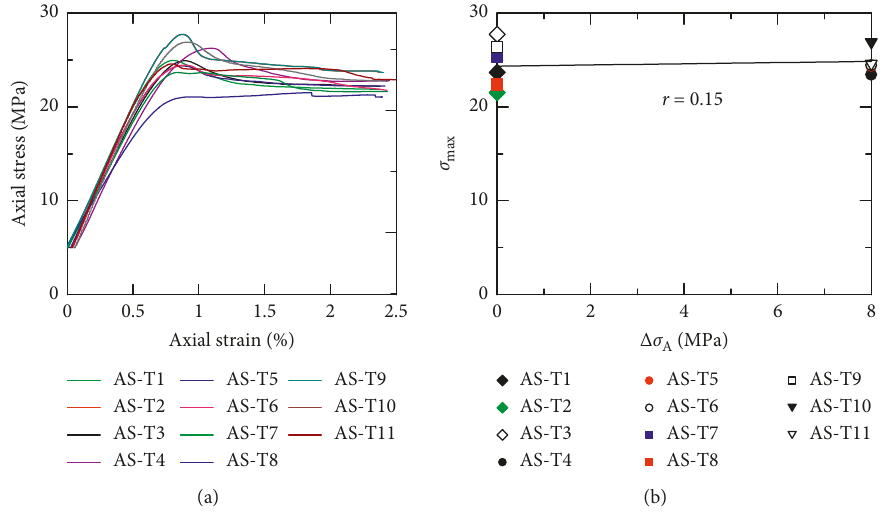
Figure 15: (a) Stress-strain curves and (b) maximum stress ( σ